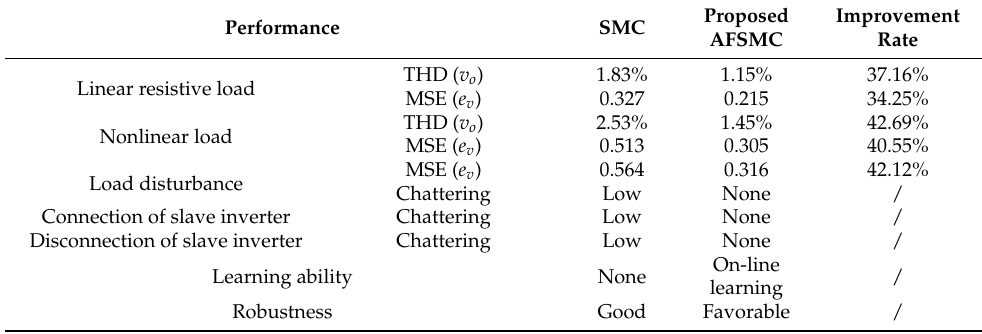
Table 2. Performance comparisons of SMC and proposed